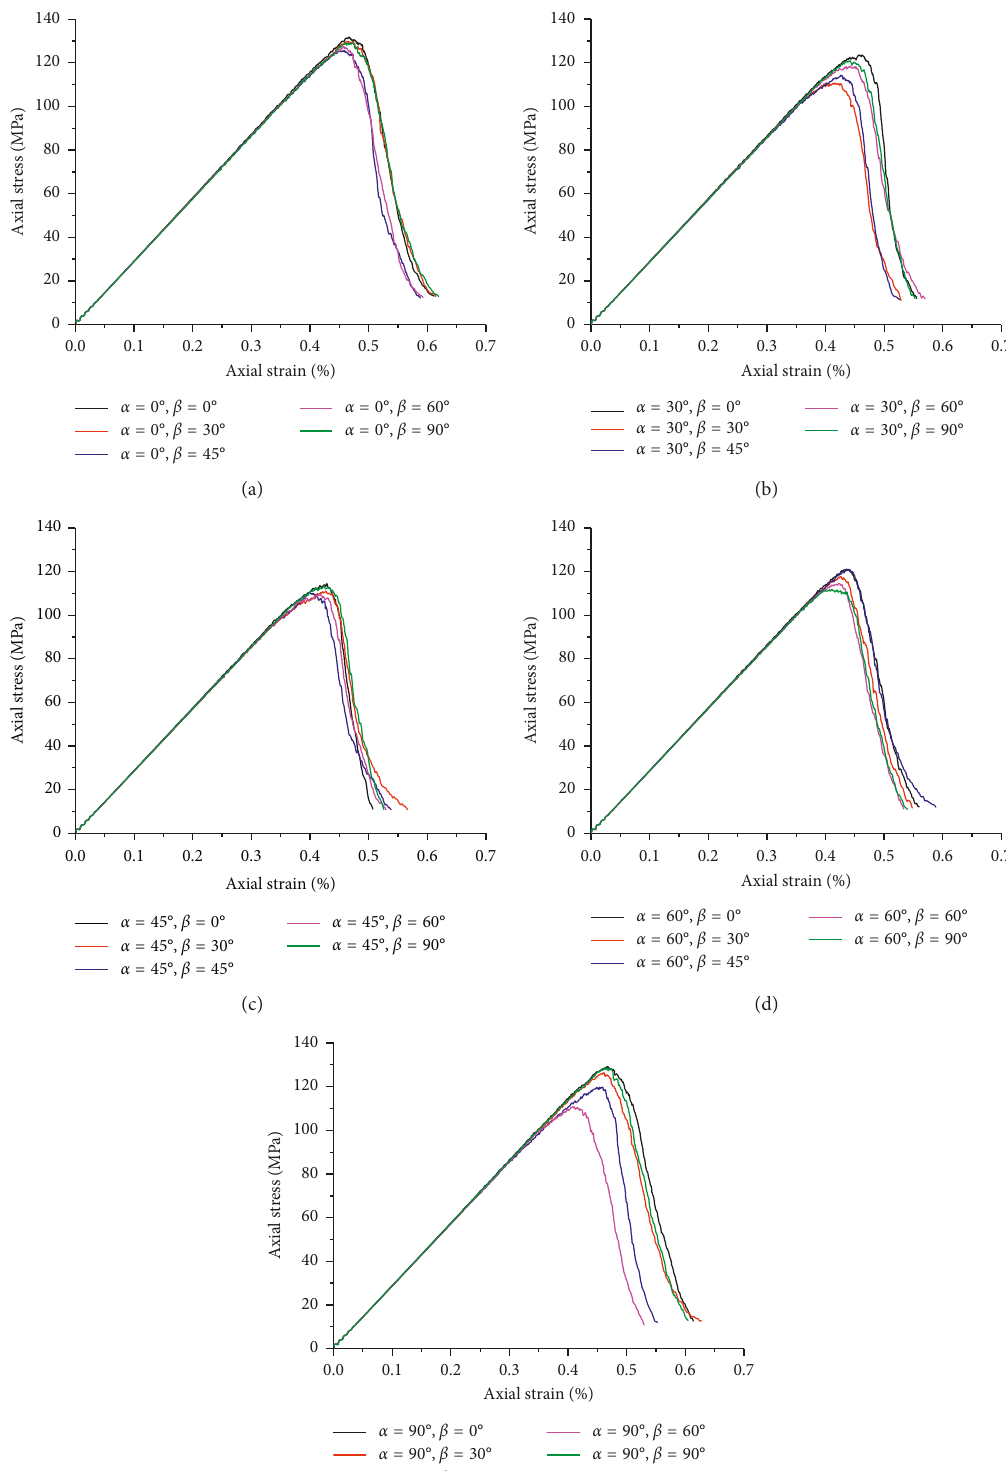
Figure 4: Stress-strain curves of the granite specimens under a definite value of α . (a) α